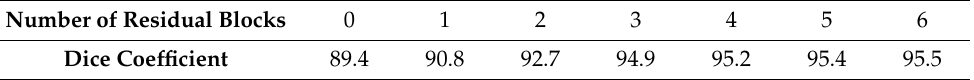
Table 3. The relationship between the number of residual blocks and Dice coefficient.